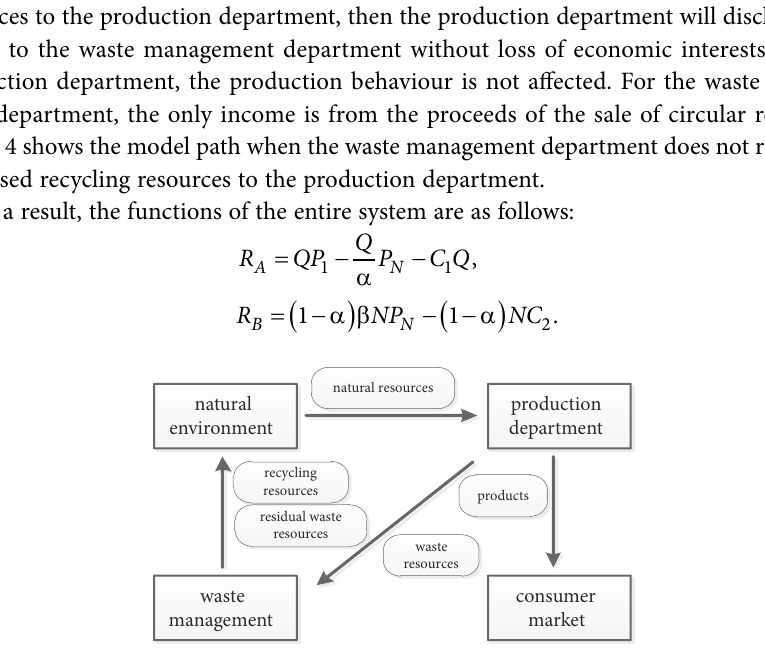
Figure 4. No recycling resource return